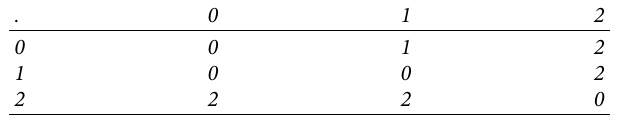
Table 2: A WUP-algebra which is not a UP-algebra. .